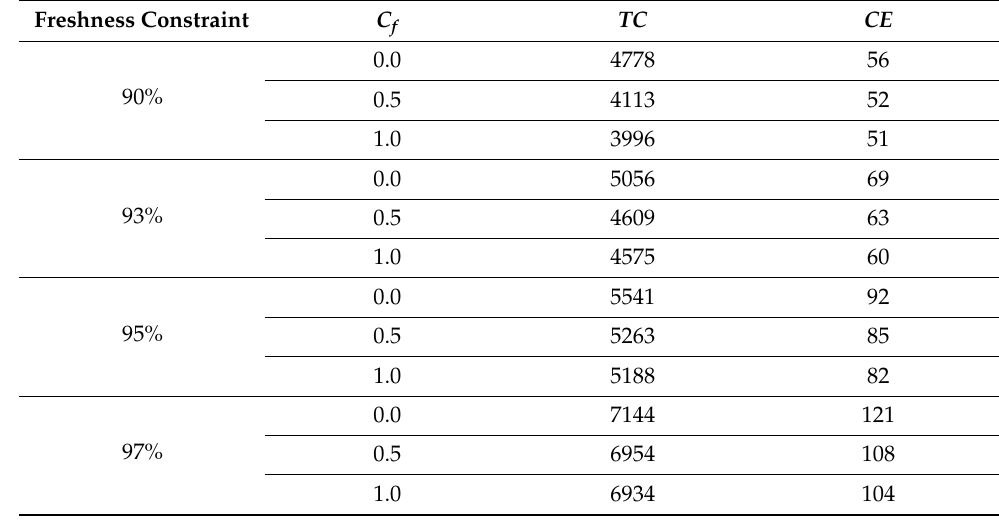
Table 3. TC and CE corresponding to different freshness constraints and different C f values.